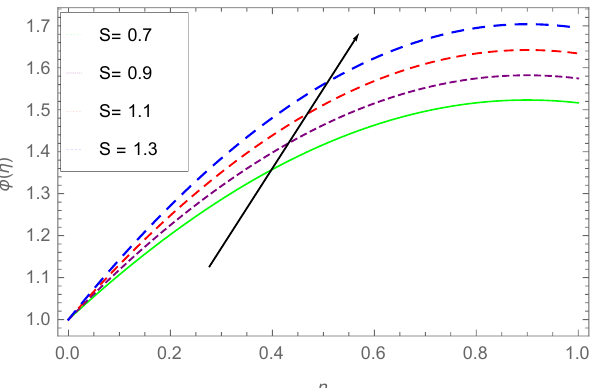
Figure 14. Impact of S on φ ( η ) , when Sc = 0.7, (cid:101) = 0.8, β = 0.9, Pr = 0.5, Nb = 0.8, Nt = 0.4.